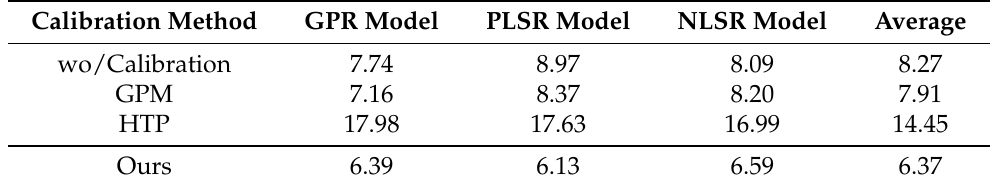
Table 1. Absolute mean error (degree) on different calibration methods and pre-trained models. GPM: Gaussian process mapping, HTP: homography transform mapping.